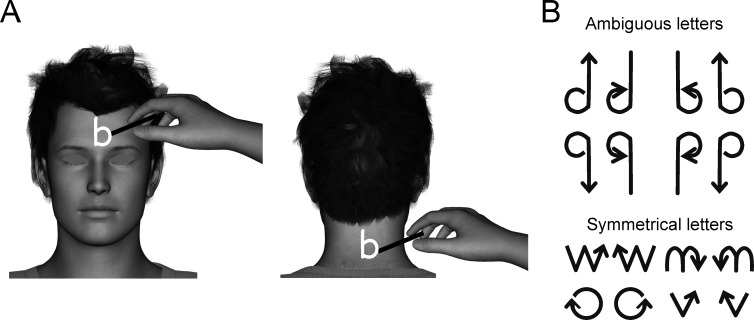
Methods for the graphaesthesia task (Experiment 2).(A) The experimenter drew letters on the participants’ forehead and neck by using a cotton bud while participants kept their eyes closed. (B) Letters included ambiguous, non-symmetrical letters (b, d, p, q) and non-ambiguous, symmetrical letters (w, n, o, v) that were all drawn in the canonical direction of writing or in the reverse direction, starting from the opposite end of the letter. All letters were drawn by using a single and continuous hand motion.